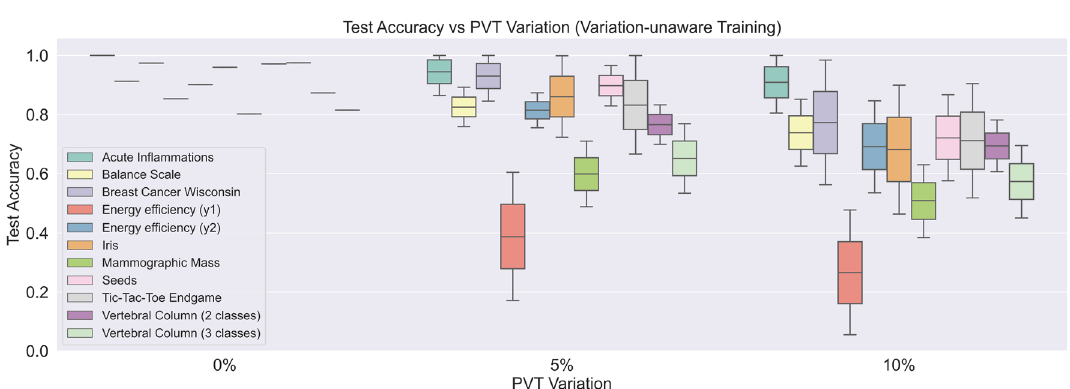
Figure 5. The proposed procedure allows for an on-demand design and fabrication given a specification of a desired functionality. While the on-demand design is realized through training a pNN according to the specification, the derived design can be readily fabricated through the on-demand fabrication capabilities of inkjet-printed electronics.